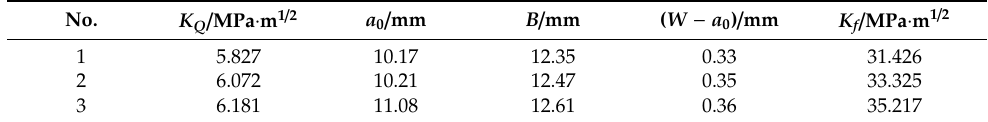
Table 4. K IC data from calculation.